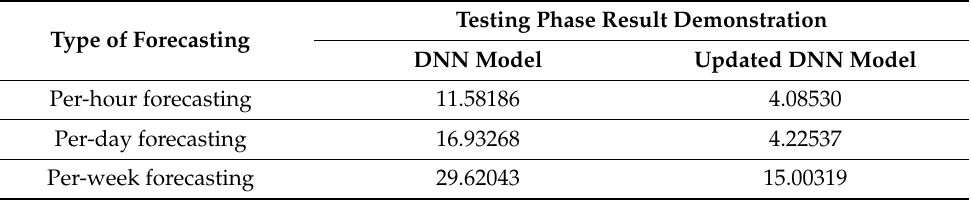
Table 3. DNN Based Result Demonstration with and without Updating the DNN